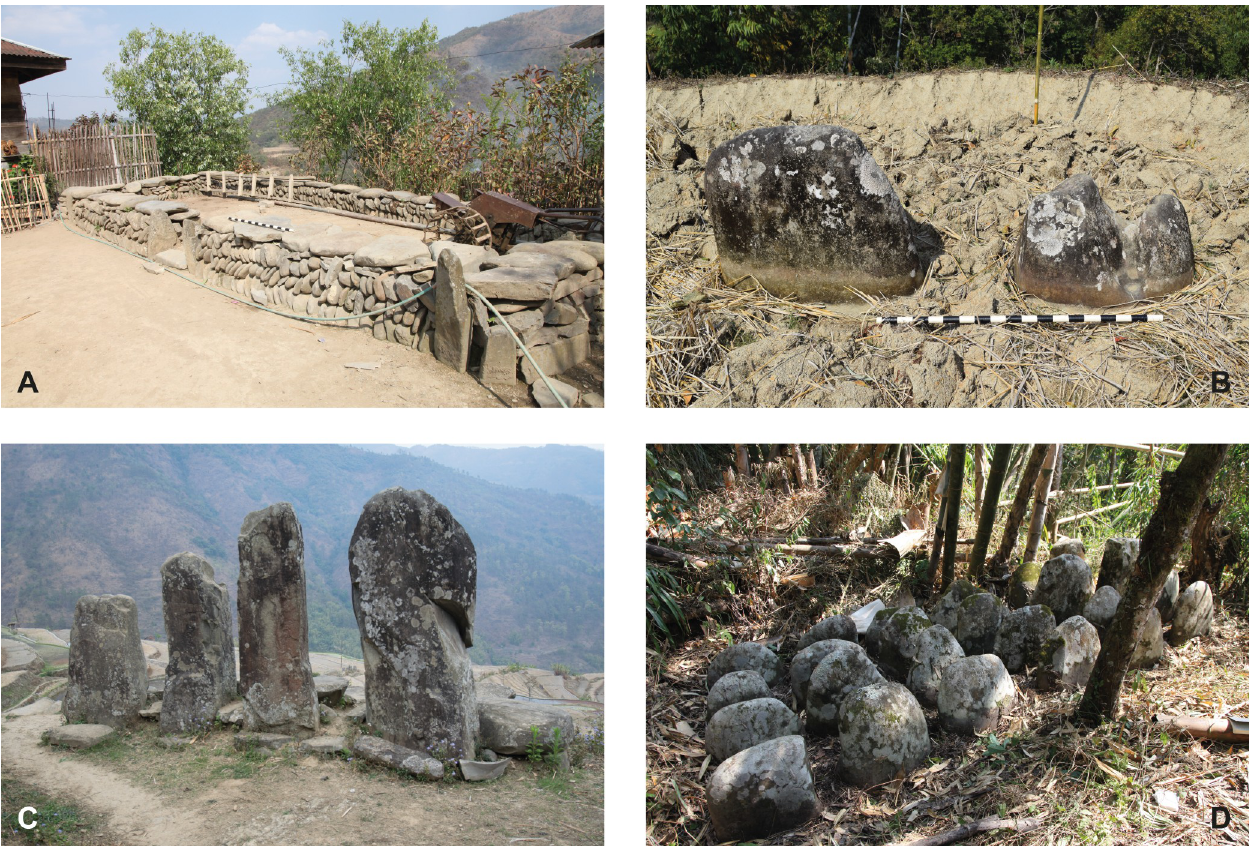
Fig 6. The different types of megalithic monuments present in Ru¨nguzu: A: Sitting platform (Photo: K. Rassmann, RGK Frankfurt), B: Standing stones without platform (Photo: M. Wunderlich), C: Stone row with a small stone platform (Photo: S. Jagiolla, graphics department of the Institute of Pre- and Protohistoric Archaeology Kiel), D: Stone field/cluster (Photo: K. Rassmann, RGK